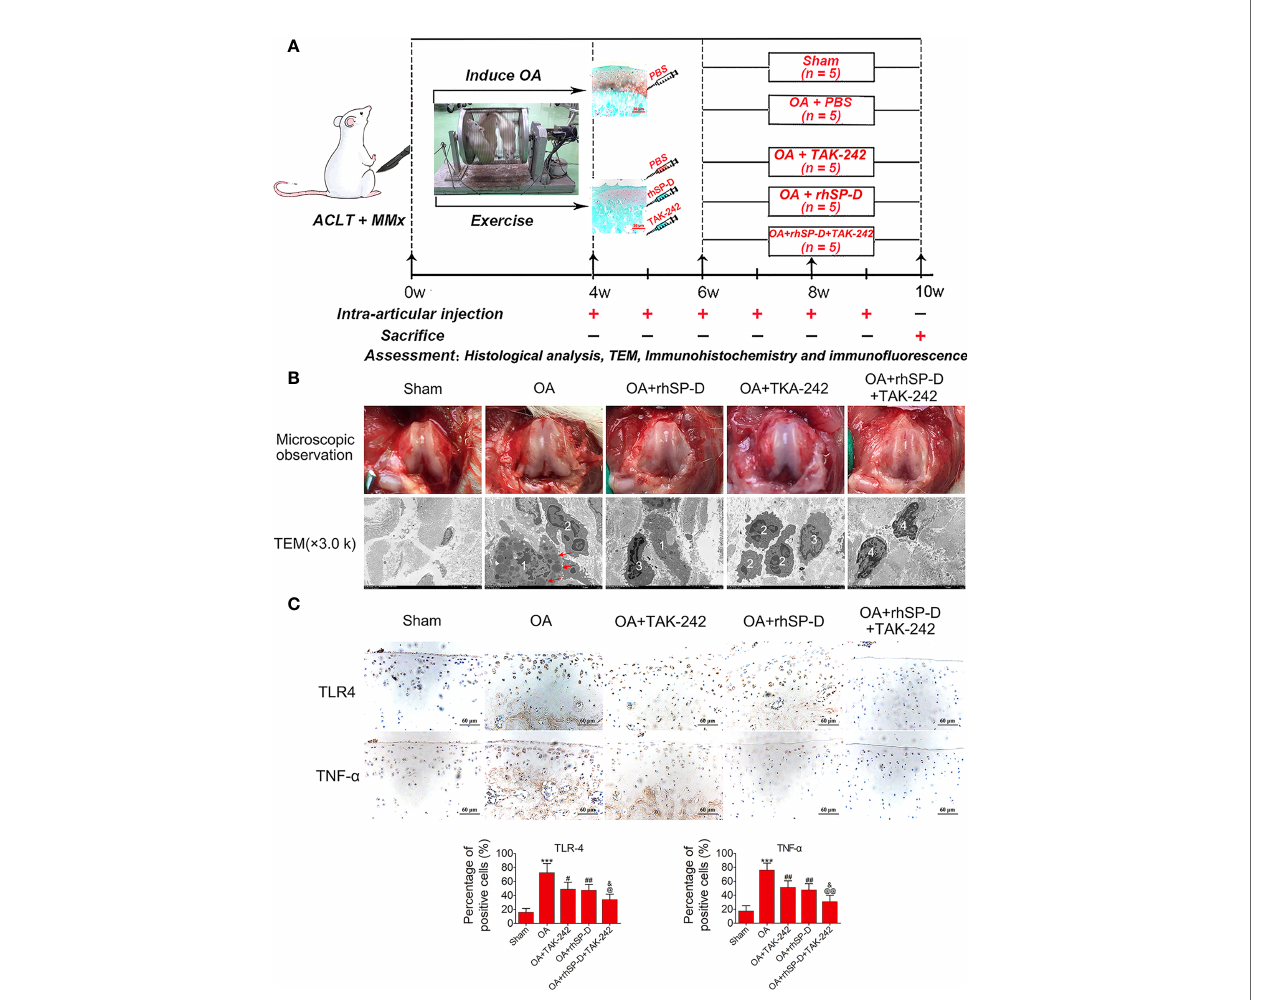
FIGURE 3 | An overview of study timelines and suppression of in fl ammatory and immune responses by SP-D in the rat OA model. (A) The ACLT + MMx rats were put into an electronic rotator cage for 30 min per day as a means of inducing OA model beginning 1 week post-surgery. At 4 weeks post-surgery, animals were injected intra-articularly with different concentrations of rhSP-D and TAK-242 once per week. PBS was used as controls in sham and OA model animals. At 10 weeks post-operation, the animals were euthanized by cardiac exsanguination. Histological staining, immunohistochemistry, immuno fl uorescence, and TEM were used for detection. (B) Microscopic observation and synovial immune cells in fi ltration were assessed via TEM (3,000 ×). 1 = macrophage;2 = neutrophil;3 = lymphocyte;4 = synovial fi broblast;The red arrows represented lysosomes. (C) Immunohistochemical staining of TLR4 and TNF- a in ACLT + MMx-induced OA rats with the administration of rhSP-D and TAK-242. The ratios of immunoreactive cells were quanti fi ed. Data were expressed as mean ± SEM (n = 5). ***P < 0.001 vs. the sham- operated group; # P < 0.05 and ## P < 0.01 vs. the OA-induction group; & P < 0.05 vs. OA + rhSP-D group; @ P < 0.05 and @@ P < 0.01 vs. OA + TAK-242